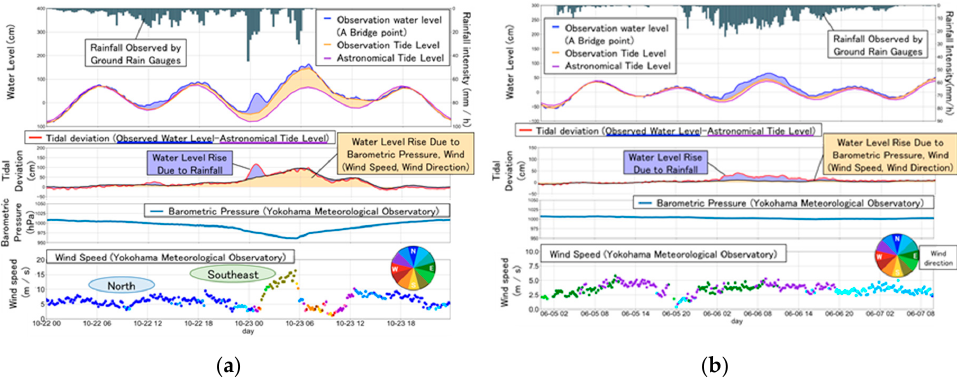
Figure 5. The relationship between water level deviation and weather conditions: ( a ) at the time of Typhoon Saola making landfall in 2017; and ( b ) during a heavy rain event in 2014.